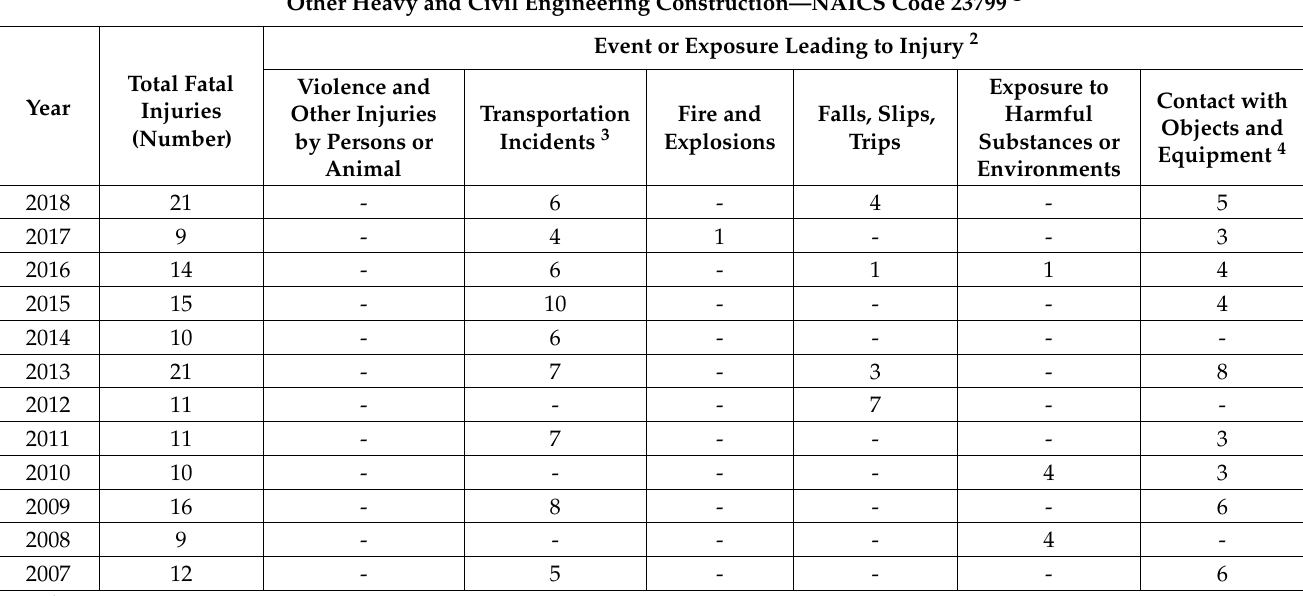
Table 1. Causes of fatal injuries in “Other Heavy and Civil Engineering Construction” sector, occurring in the United States from 2007 to 2018 (source: OSHA—Bureau of Labor statistics).